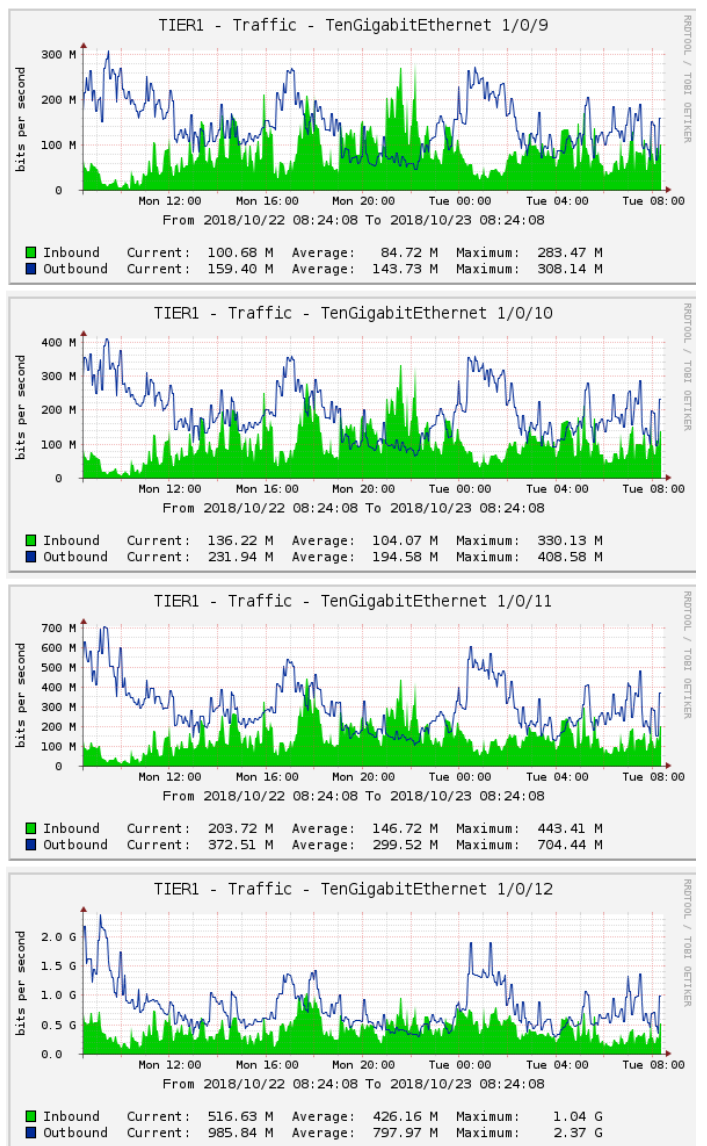
Fig. 4. Example of data loading capacity in a random similar four communication lines. The curves analysis allows to pay attention to the similar nature of behaviour of sent and received traffic via each communication line. Only vertical axis values differ. However, this difference is not systematic. The ratio is